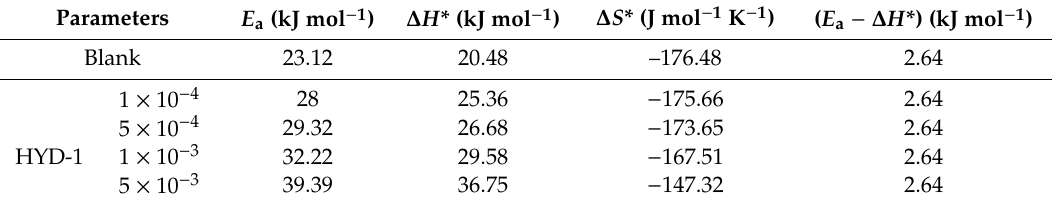
Table 2. Thermodynamic activation parameters for the mild steel (MS) electrode in 1.0 M HCl in the presence and absence of di ff erent concentrations of